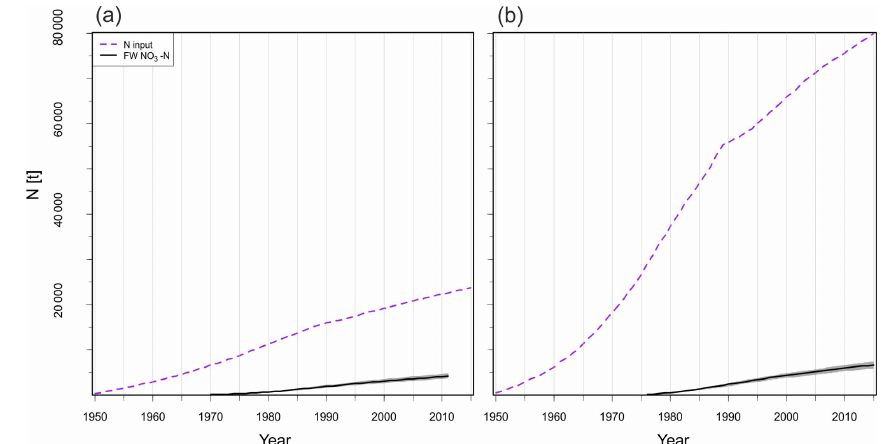
Figure 4. Cumulative annual diffuse N inputs to the catchment and measured cumulative NO 3 –N exported load over time for mid- stream (a) and downstream (b) stations. Shaded grey confidence bands refer to the 5th and 95th percentile of the WRTDS flux estimation. Table 4. Best-fit parameters of the log-normal TTDs for the N input and output responses. Parameters in brackets are derived by using the 5th and 95th percentiles of the bootstrapped flow-normalized concentration estimates. Parameter All